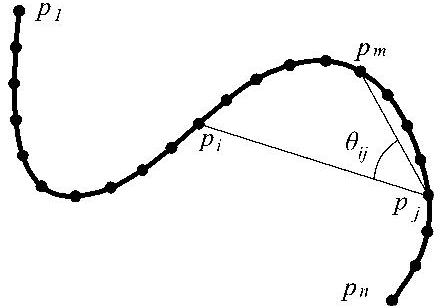
Figure 1. Definition of point p m ( (cid:49) = 4) for CAD.